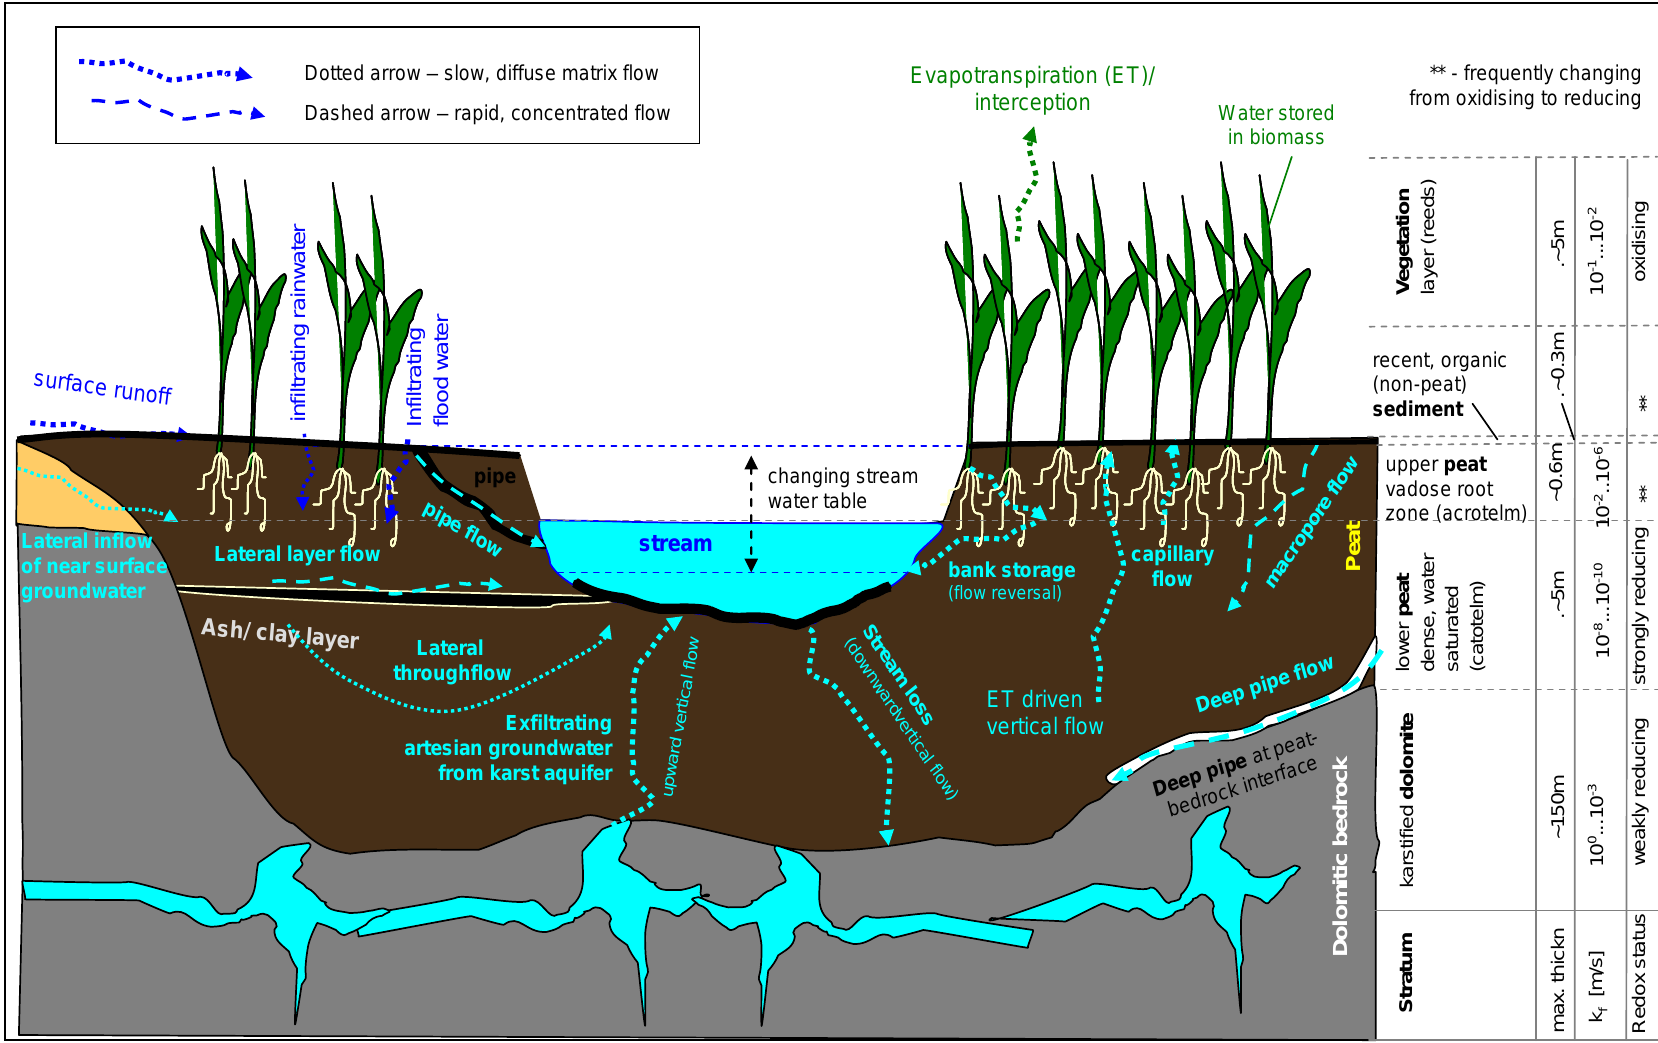
Figure 2. Overview on possible hydraulic processes in the GMB Peatland depicting different modes of surface—and groundwater moving through peat (not to scale) (hydraulic component of the U filter model for